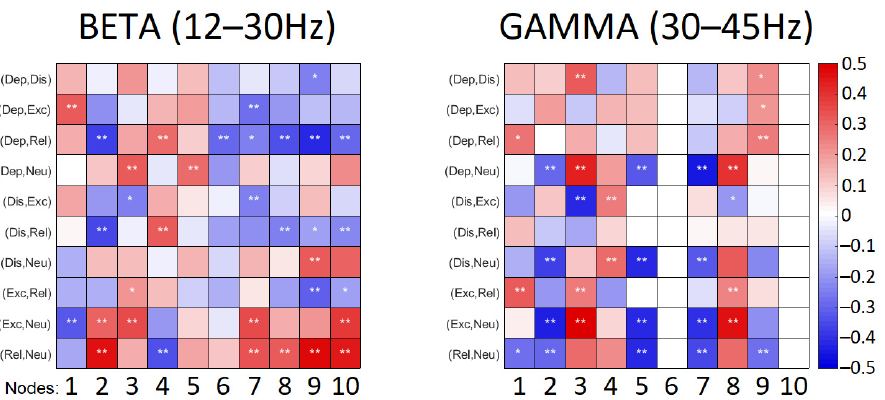
Figure 4. Results of comparison of the degrees of nodes: color codes the effect sizes corresponding to the difference in the mean of the groups and p values are marked with *: * denotes p < 0.05, ** denotes p < 0.01. Dep—depressed, Dis—distressed, Exc—excited, Rel—relaxed, Neu—neutral. ROIs are coded in numbers: mid-frontal left (1) and right (2), fronto-lateral left (3) and right (4), centro-parietal left (5) and right (6), parieto-occipital left (7) and right (8), fronto-central (9) and central parieto-occipital (10).